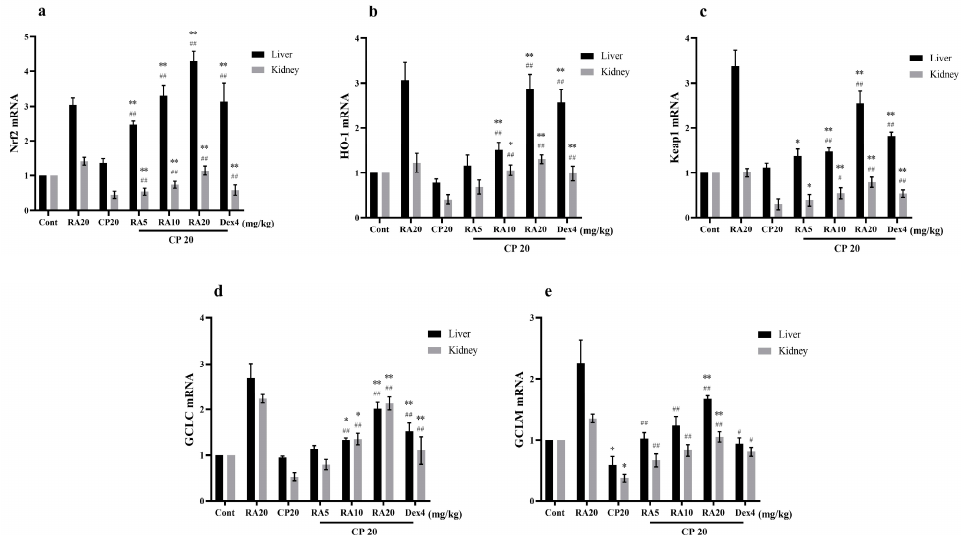
Figure 8. Effects of RA on the expression levels of Nrf2 signaling pathway-related target genes in CP- induced liver and kidney tissues. The mRNA expression levels of Nrf2 ( a ), HO-1 ( b ), Keap1 ( c ), GCLC ( d ), and GCLM ( e ) in the liver and kidney of mice were detected by qRT–PCR. These experiments were repeated three times. * and # denote significant differences ( p < 0.05) and ** and ## denote highly significant differences ( p < 0.01) compared with the control and CP model groups,